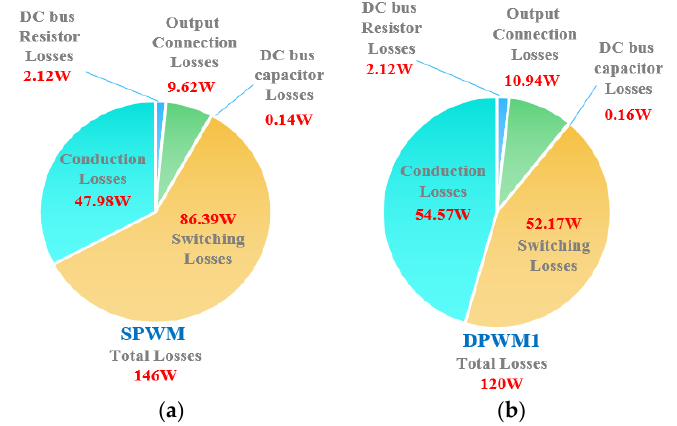
Figure 12. Loss estimation for each part of the converter based on measured losses: ( a ) losses using SPWM method at output power of 13.6 kVA; ( b ) losses using DPWM1 method at output power of 14.5 kVA.